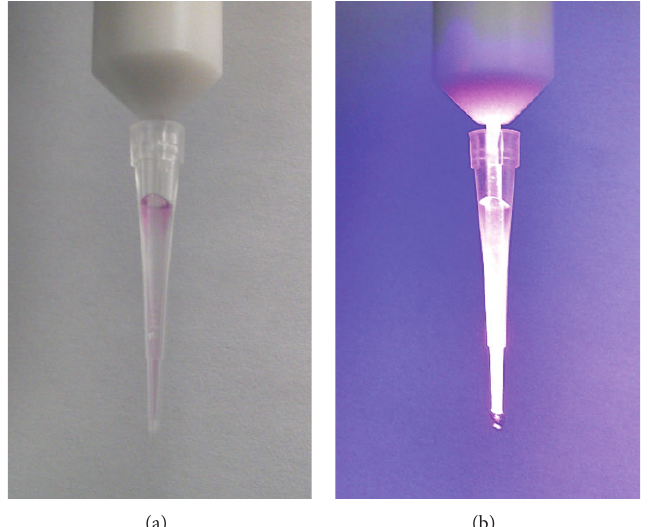
Figure3:(a)Microtipfollowingaspirationofmicrobialsolution.(b)Irradiationofthemicrobialsolutionfollowinginsertionoftheirradiation device tip into the microbial solution.